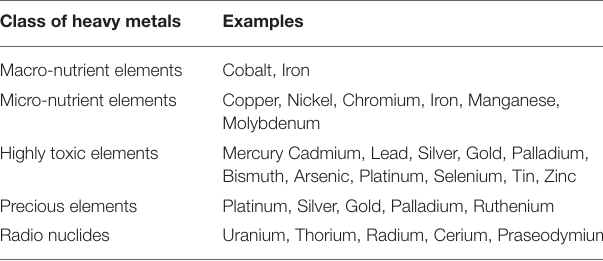
TABLE 1 | Classification of heavy metals with examples.